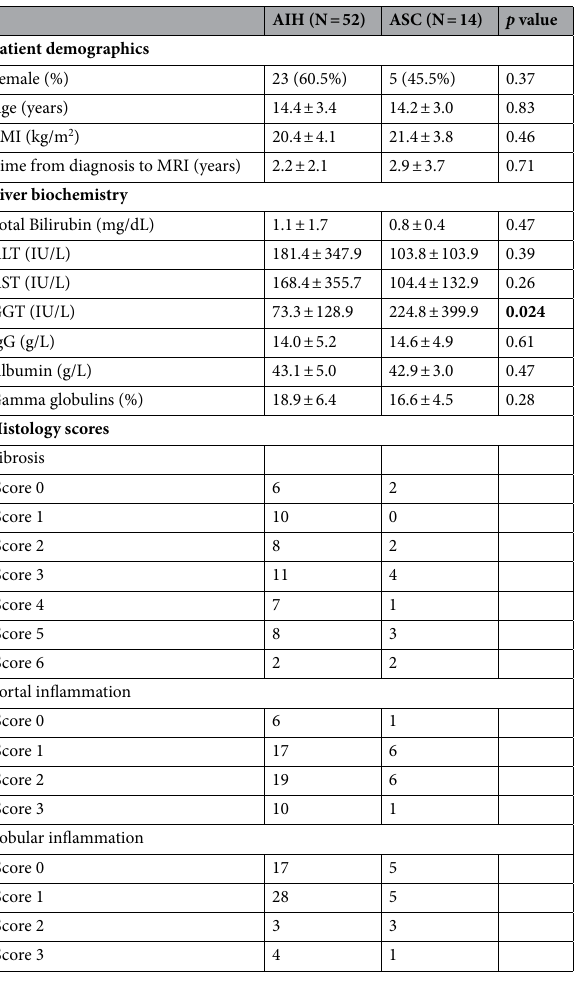
Table 1. Patient demographics and characteristics. The different section headings, significant p values, and patient groups in the column headers have bold font. They have been put in bold text to aid in the interpretation of the data